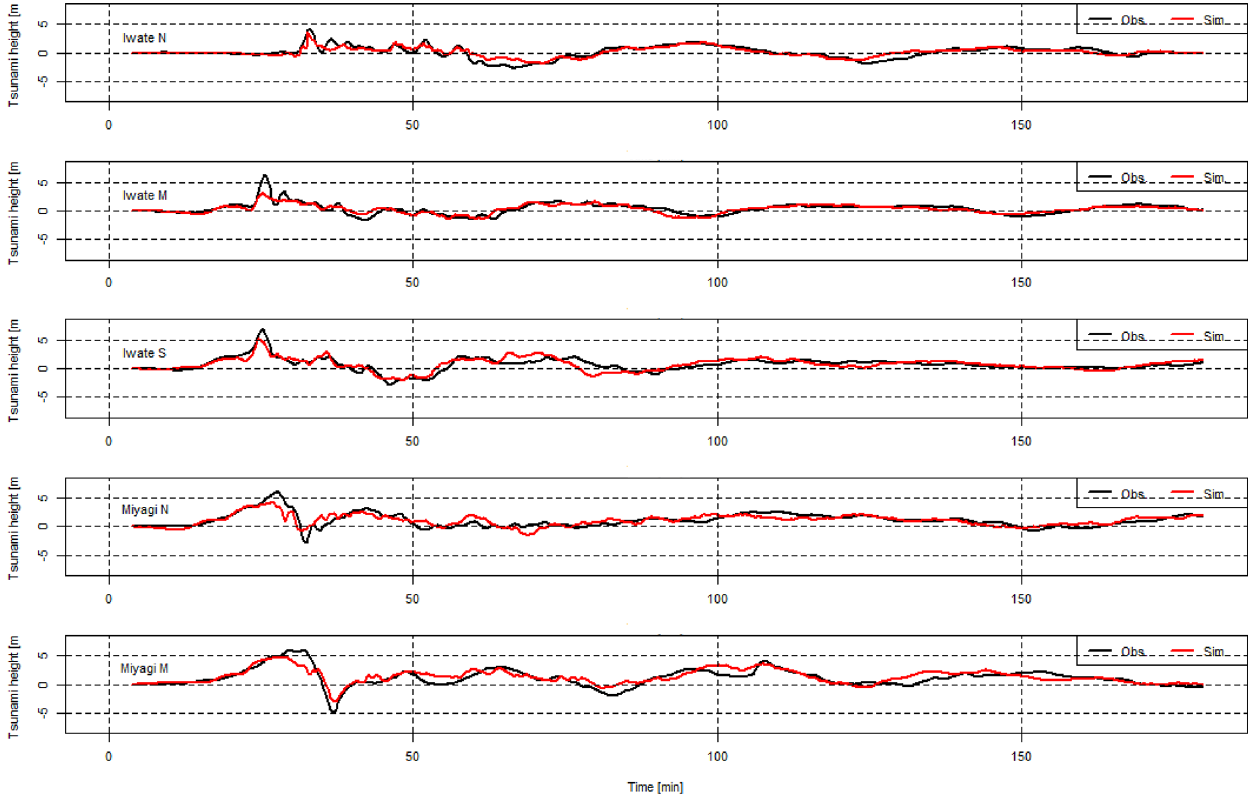
Figure 5. Comparison of tsunami height between observational data and simulation results (borrowed from Kotani et al., 2020).